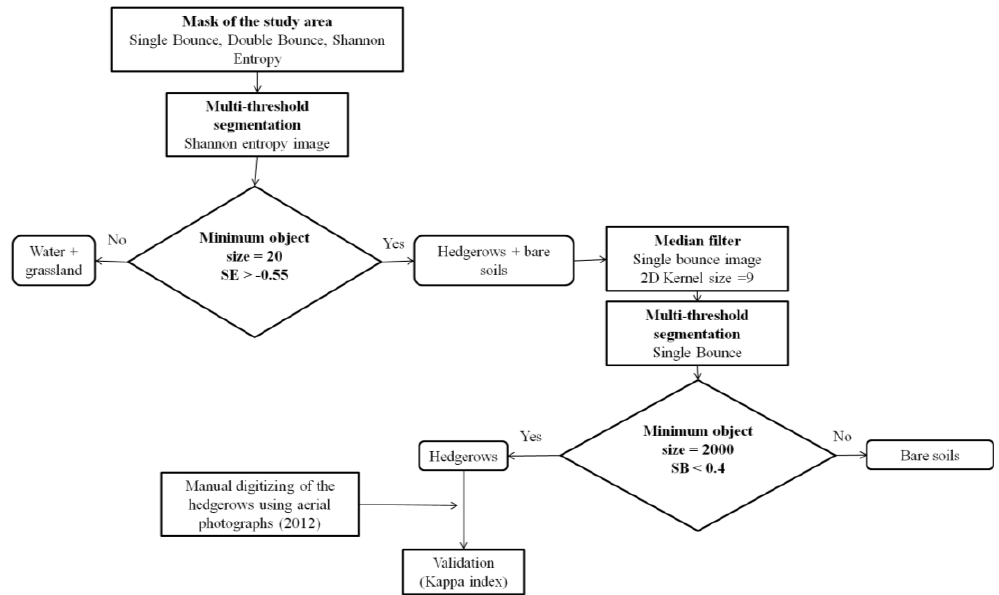
Figure 5. Workflow of hedgerow extraction using a TerraSAR-X